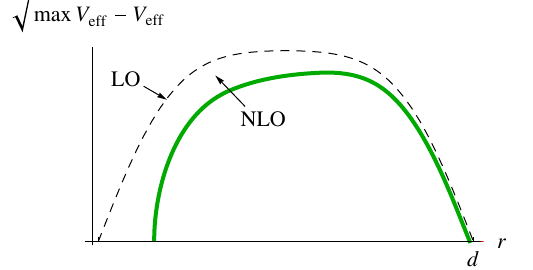
FIG. 2. Solid curve, the integrand of Eq. (12) for a tilted single- well periodic potential. Dashed curve, the R integrand. The area under it is the LO contribution [Eq. (14)]. The small area between the solid and the dashed curves at small R may be regarded as the NLO